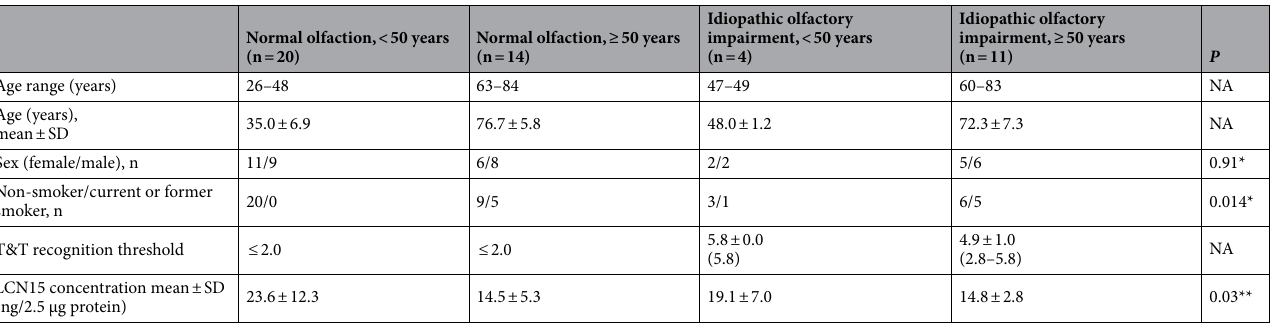
Table 1. LCN15 concentration in olfactory cleft lavage fluid. NA not assessed. *chi-square test. **one-way analysis of variance